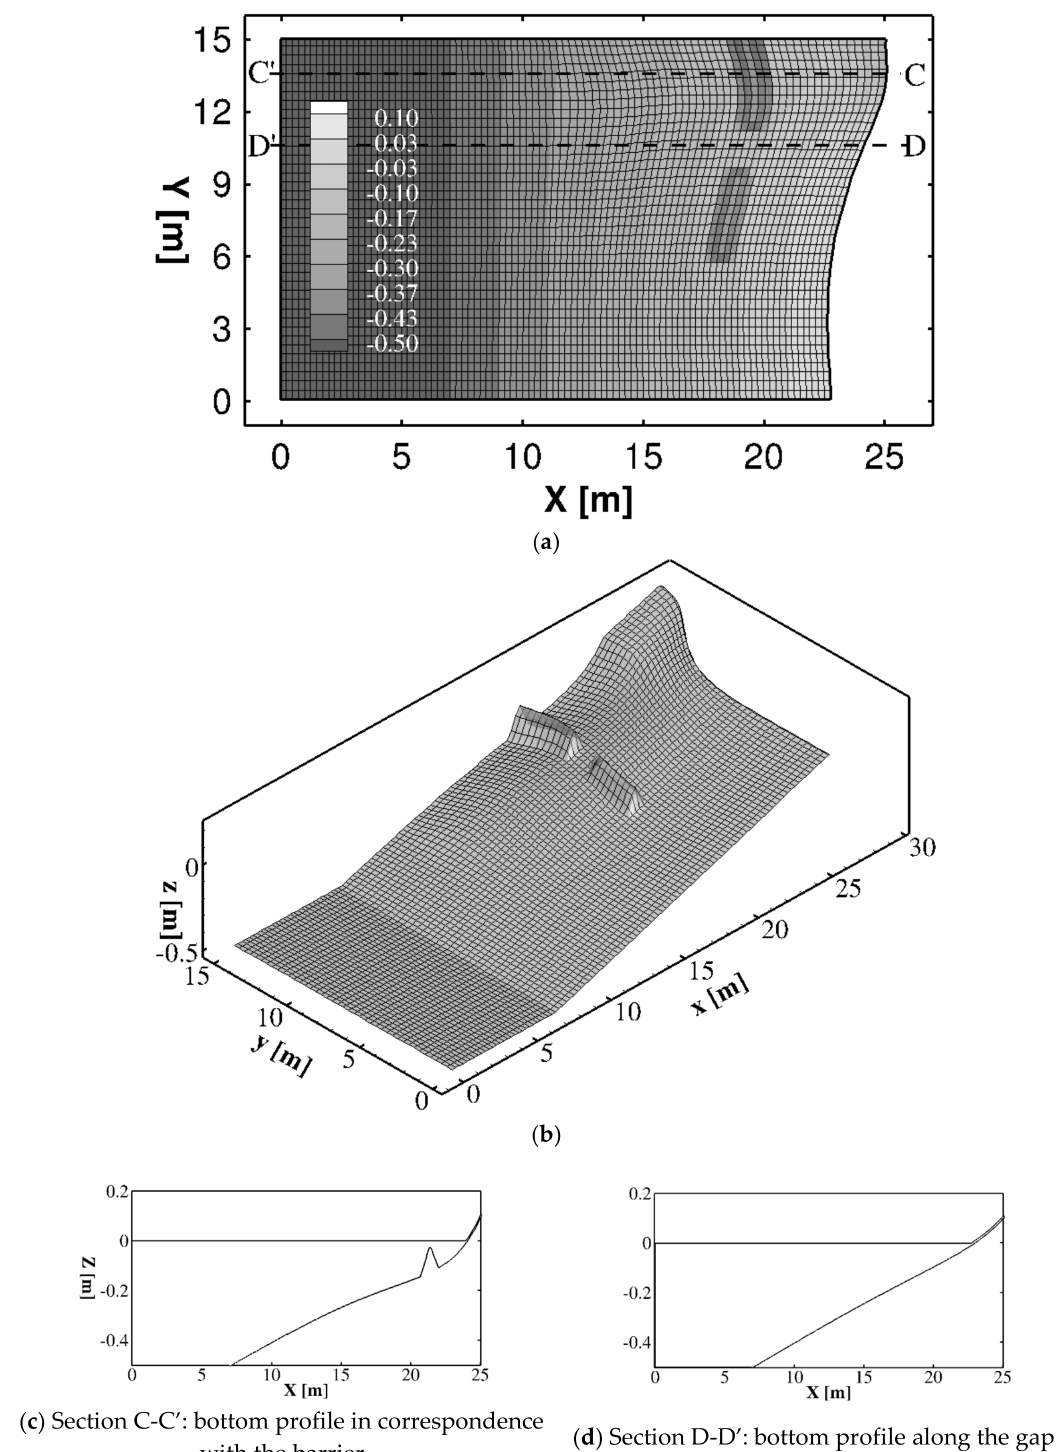
Figure 6. Case 1: ( a ): Plan view of the curvilinear computational grid (Only one out of every five coordinate lines is shown). ( b ): three-dimensional view of the bottom. ( c – d ): bottom profiles in section C-C’ and